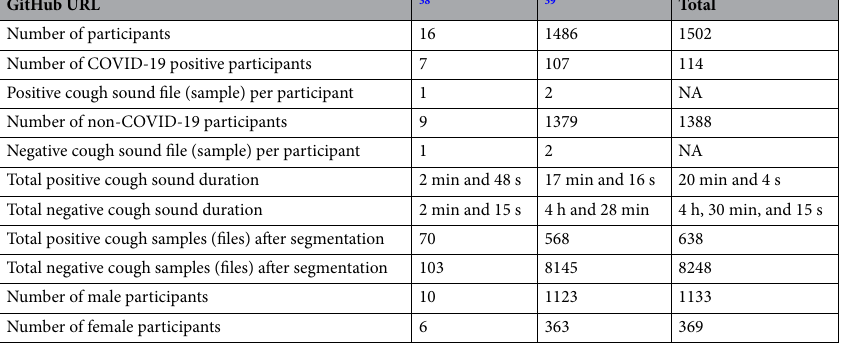
Table 13. COVID-19 cough data